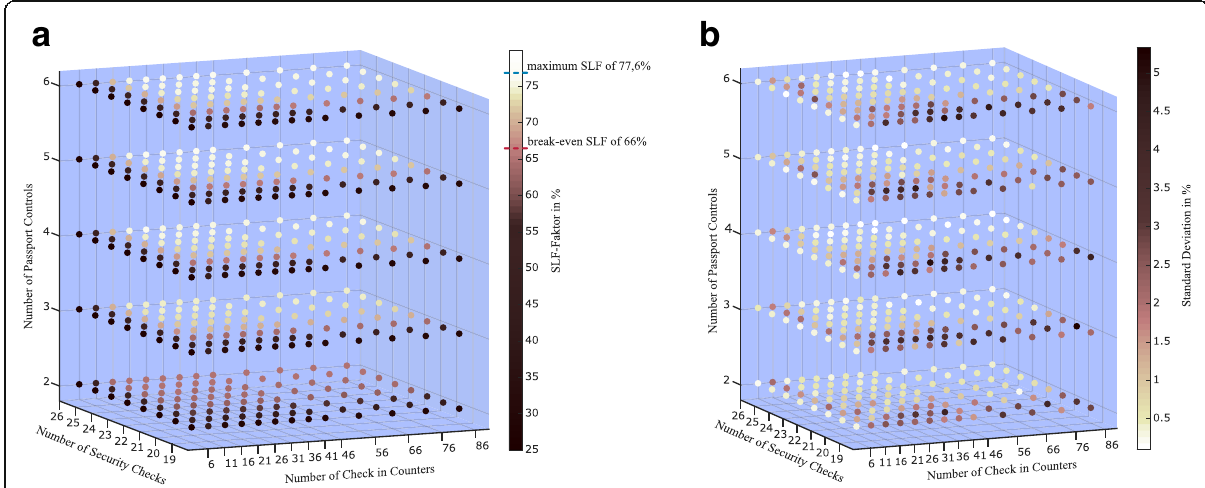
Fig. 5 Representation of the considered parameter space with the number of service counters where we carried out simulation runs. We determined the mean values and the standard deviations of the results of the runs with the five different databases. These are shown in Fig. 5 ( a ) and 5 ( b ). a Representation of the mean values. b Representation of the standard